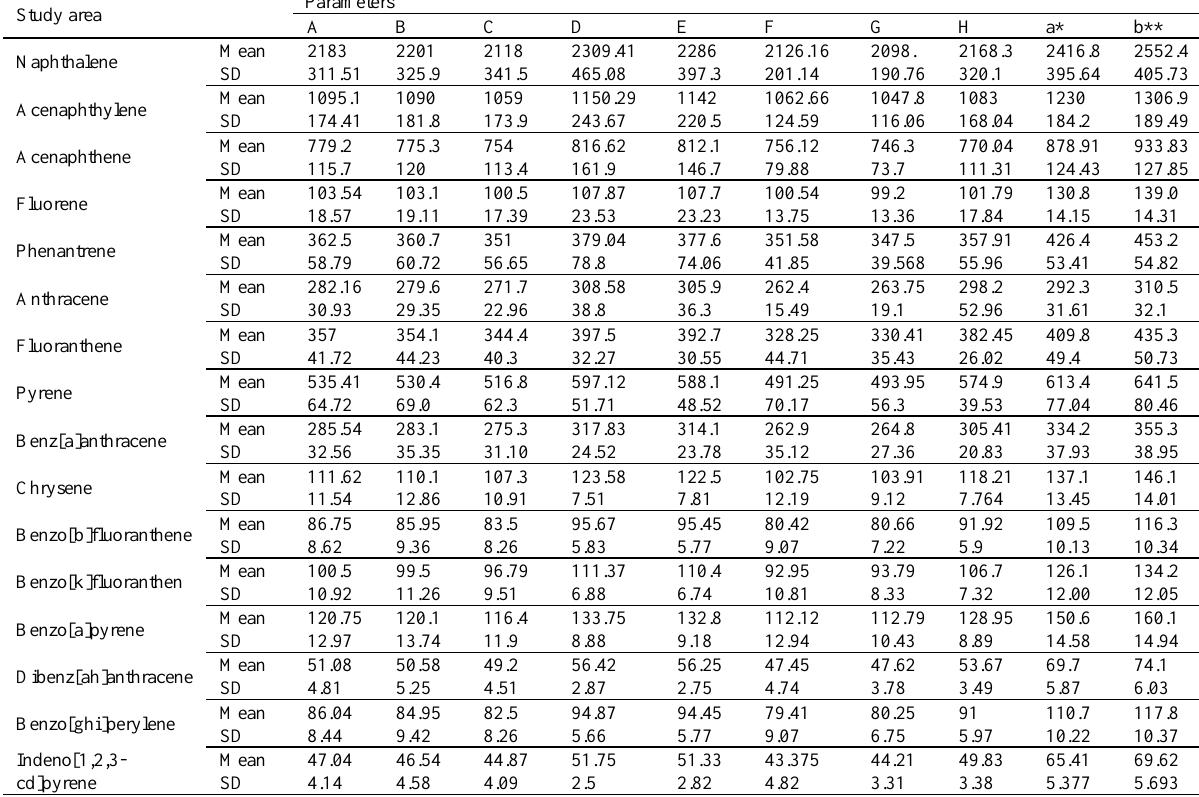
Table 7. Mean concentrations of PAHs in Tizro Grease Oil re-refining plant of Garmsar at various sampling points Study